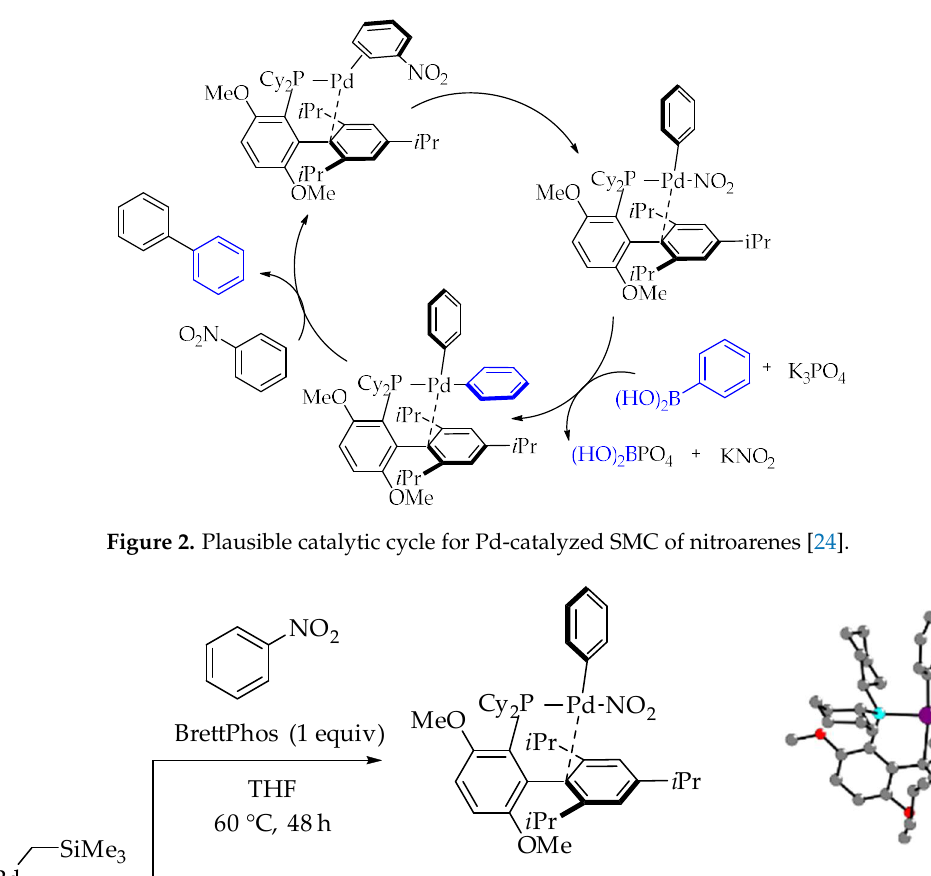
Table 1. The Suzuki–Miyaura coupling (SMC) of nitroarenes with various substrates ( a Isolated yield after hydrolysis of the corresponding acetals. b Reaction with CsF) [24].